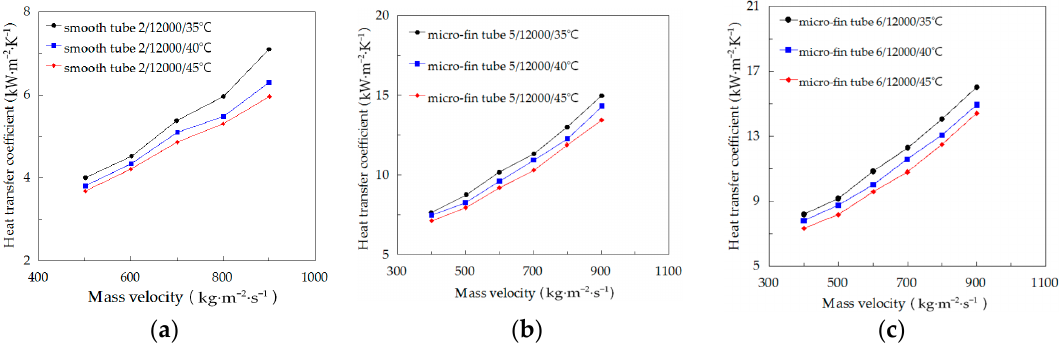
Figure 7. Influence of mass velocity and condensation temperature on the heat transfer coefficient inside ( a ) tubes 2; ( b ) 5; and ( c ) 6 for R134a.